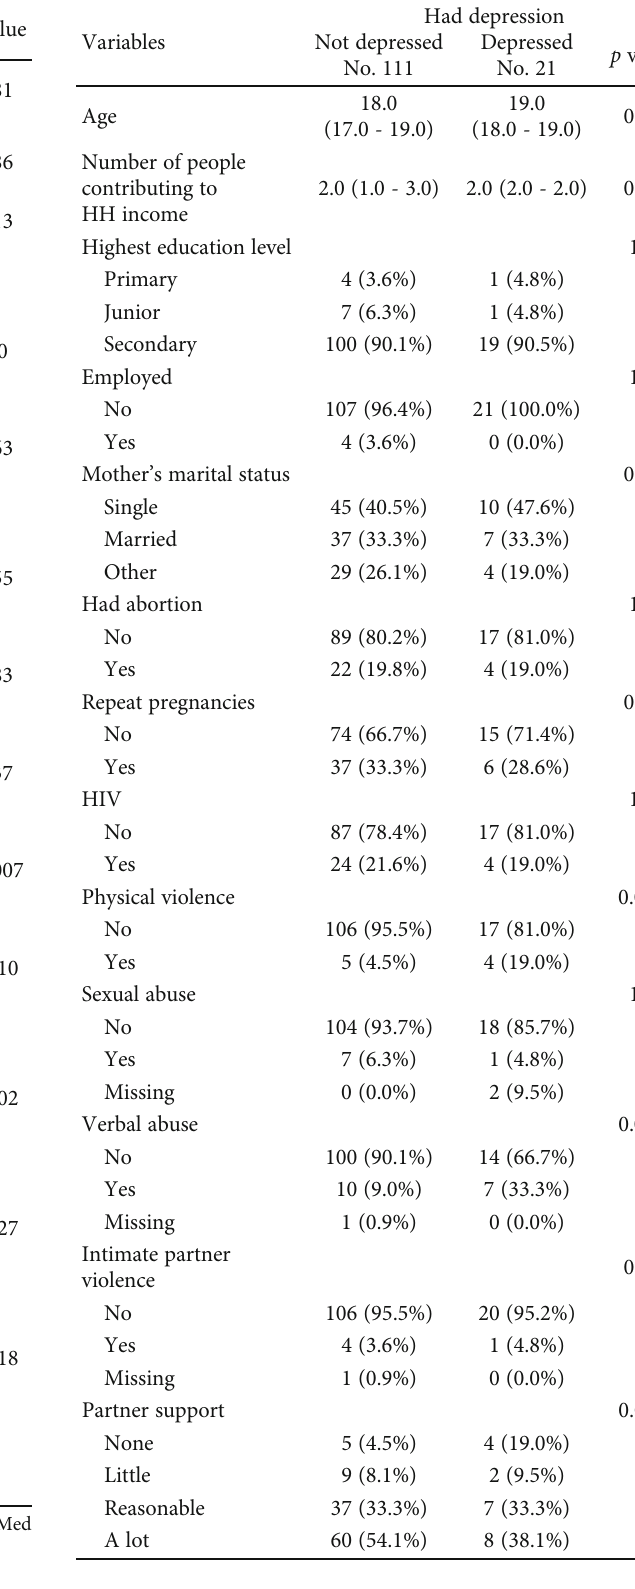
Table 4: Comparison of risk factors for participants who had depression versus those who did not ( n = 326 ).